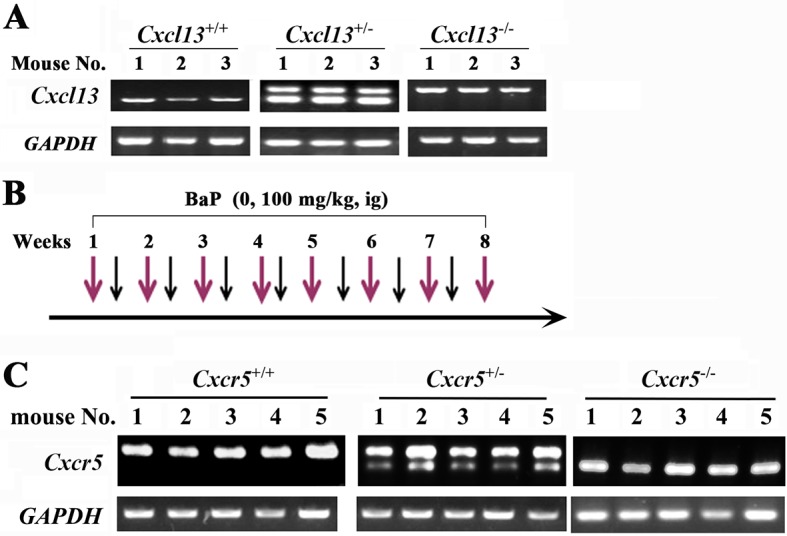
Treatment of Cxcl13-/- and Cxcr5-/- mice with benzo(a)pyrene (BaP).(A) The expression of Cxcl13 in the mice. (B) Schematic represents the protocols for administration of BaP in the mice. (C) The expression of Cxcr5 in the mice.